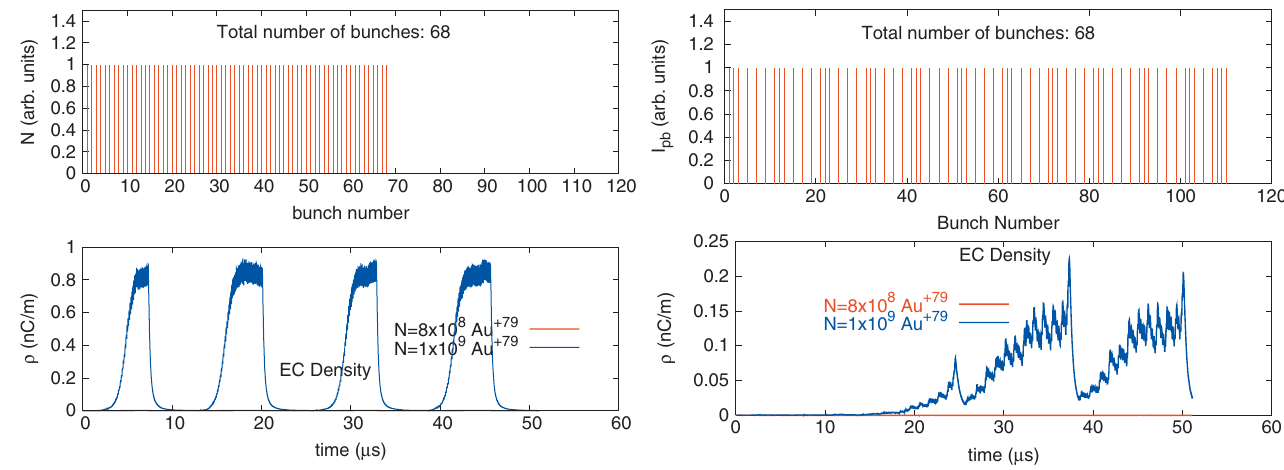
FIG. 19. (Color) Simulated electron cloud evolution over 4 turns for 68 Au bunches with a single gap of maximum lengths (top), and 68 bunches distributed approximately uniformly around the circumference